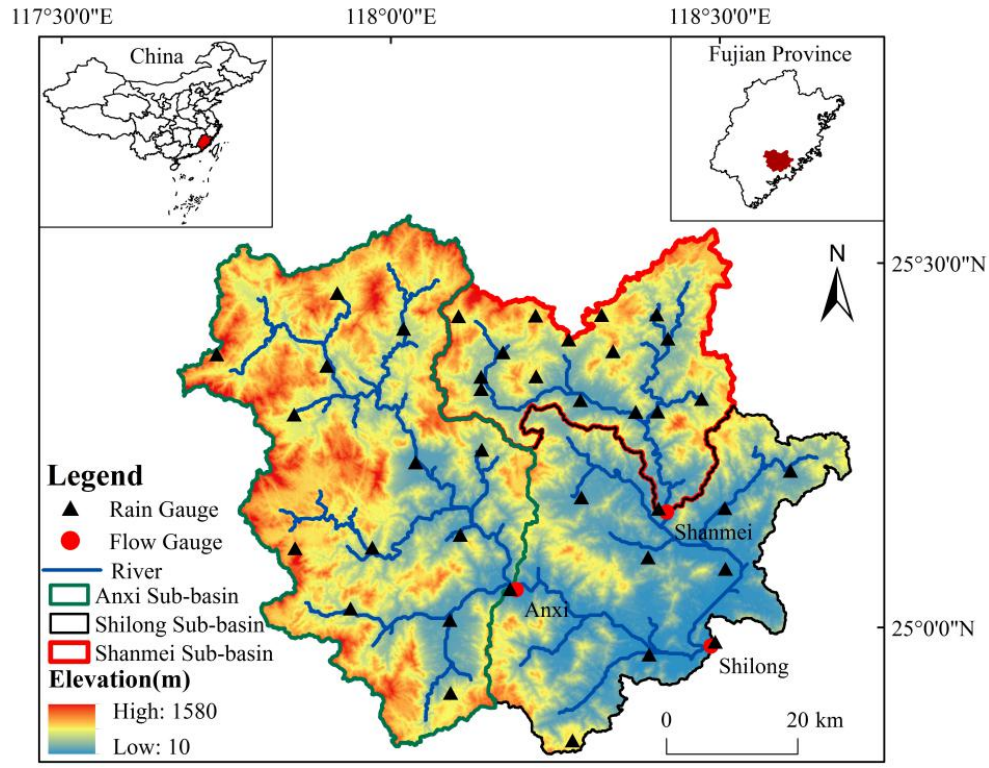
Figure 1. Location of the rain gauges in the Jinjiang Basin.